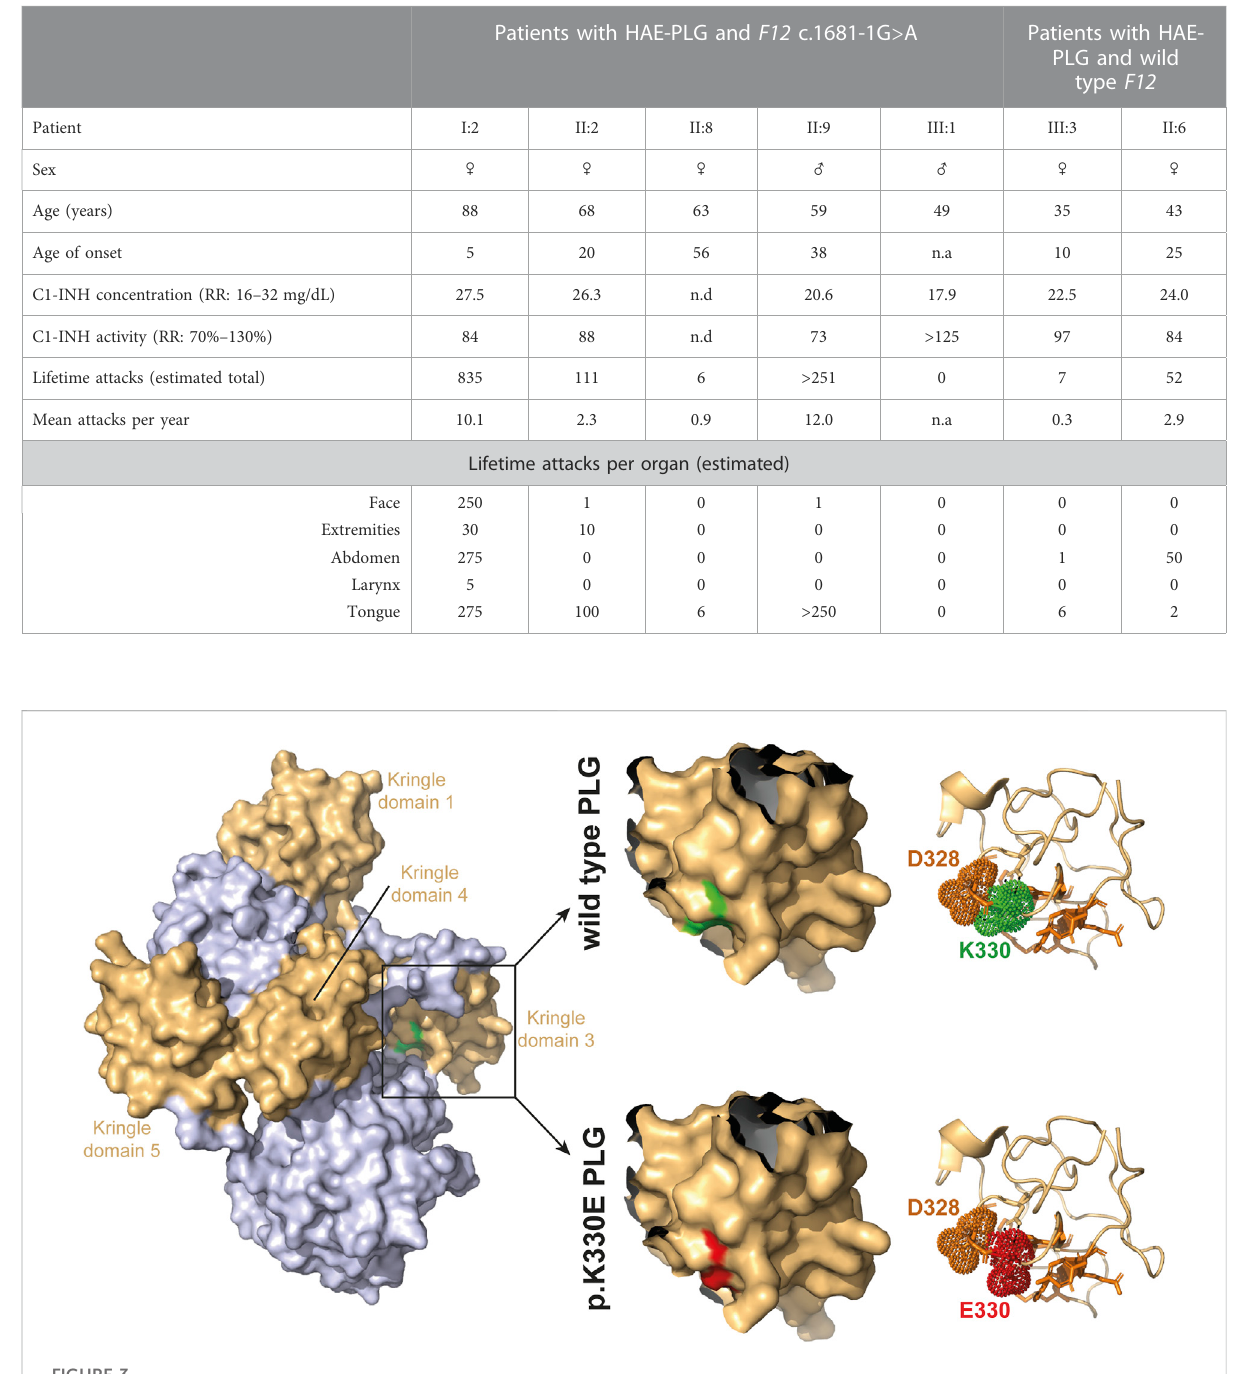
FIGURE 3 Crystal structure of human plasminogen. The structure is shown in surface (left and middle) and cartoon (right) representations colored in grey withtheKringledomains1-5highlightedinlight-orange.Cartoonpresentations(right)indicatetheligandbindingresiduesasorangesticks,andK330 (green) and the interacting amino acid D328 (orange) as well as the mutation E330 (red) as dots. Structural views of plasminogen (Protein Data Bank entry 4A5T) (Xue et al., 2012) were generated by using the PyMOL Molecular Graphics System, Version 2.4 (Schrödinger